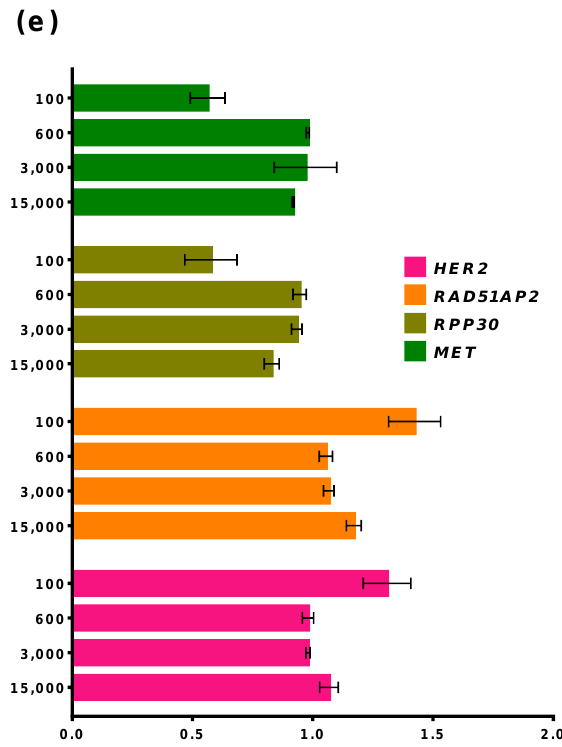
Figure 7. Influence of DNA amount on ddPCR performance. ( a ) 15,000 copies per reaction; ( b ) 3000 copies per reaction; ( c ) 600 copies per reaction; ( d ) 100 copies per reaction; ( e ) FFPE NSCLC sample titration. Each specimen was analyzed in duplicate. X-axis represents the ratio of target or reference gene concentration to normalized concentration of both reference genes, and Y-axis shows the DNA sample. Whiskers designate standard deviation in two experiments.